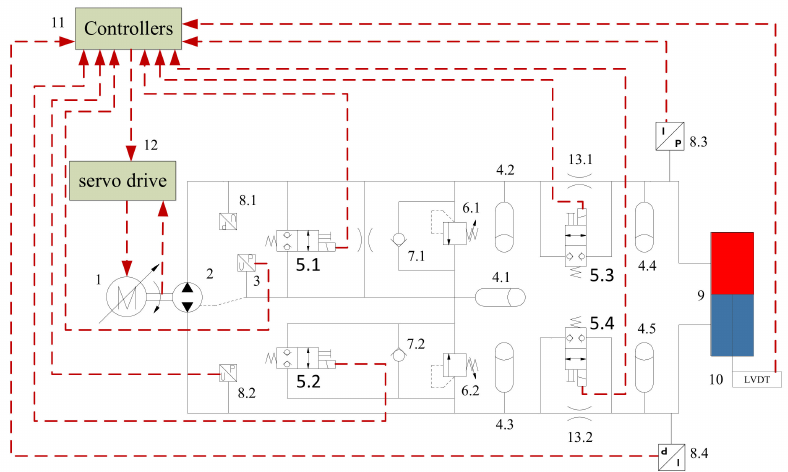
Figure 3. Schematic of the ESPCS structure: 1—servo motor; 2—fixed-displacement pump;